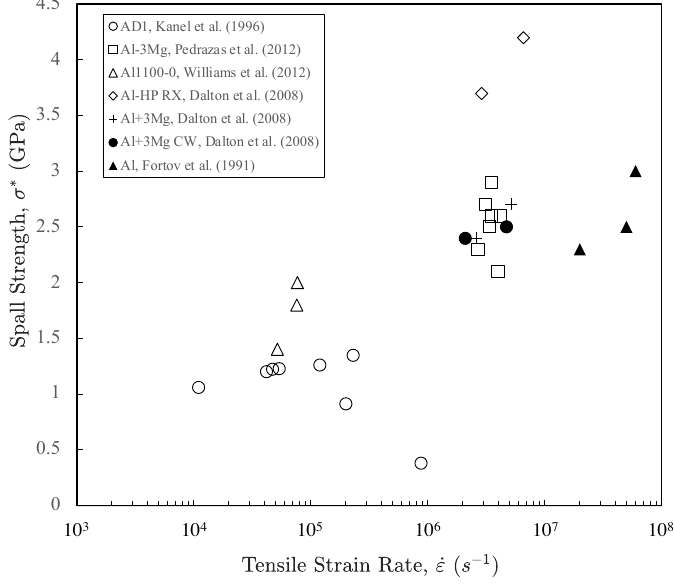
Figure 3. Spall strength as a function of tensile strain-rate determined from time-resolved ve- locimetry measurements on pure and alloyed Al from the open literature. Reproduced or adapted from